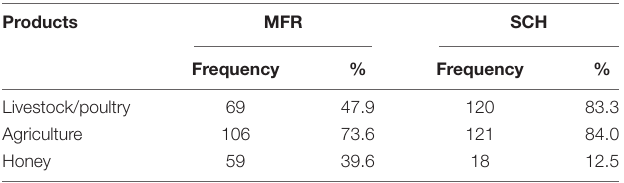
On-farm strategies